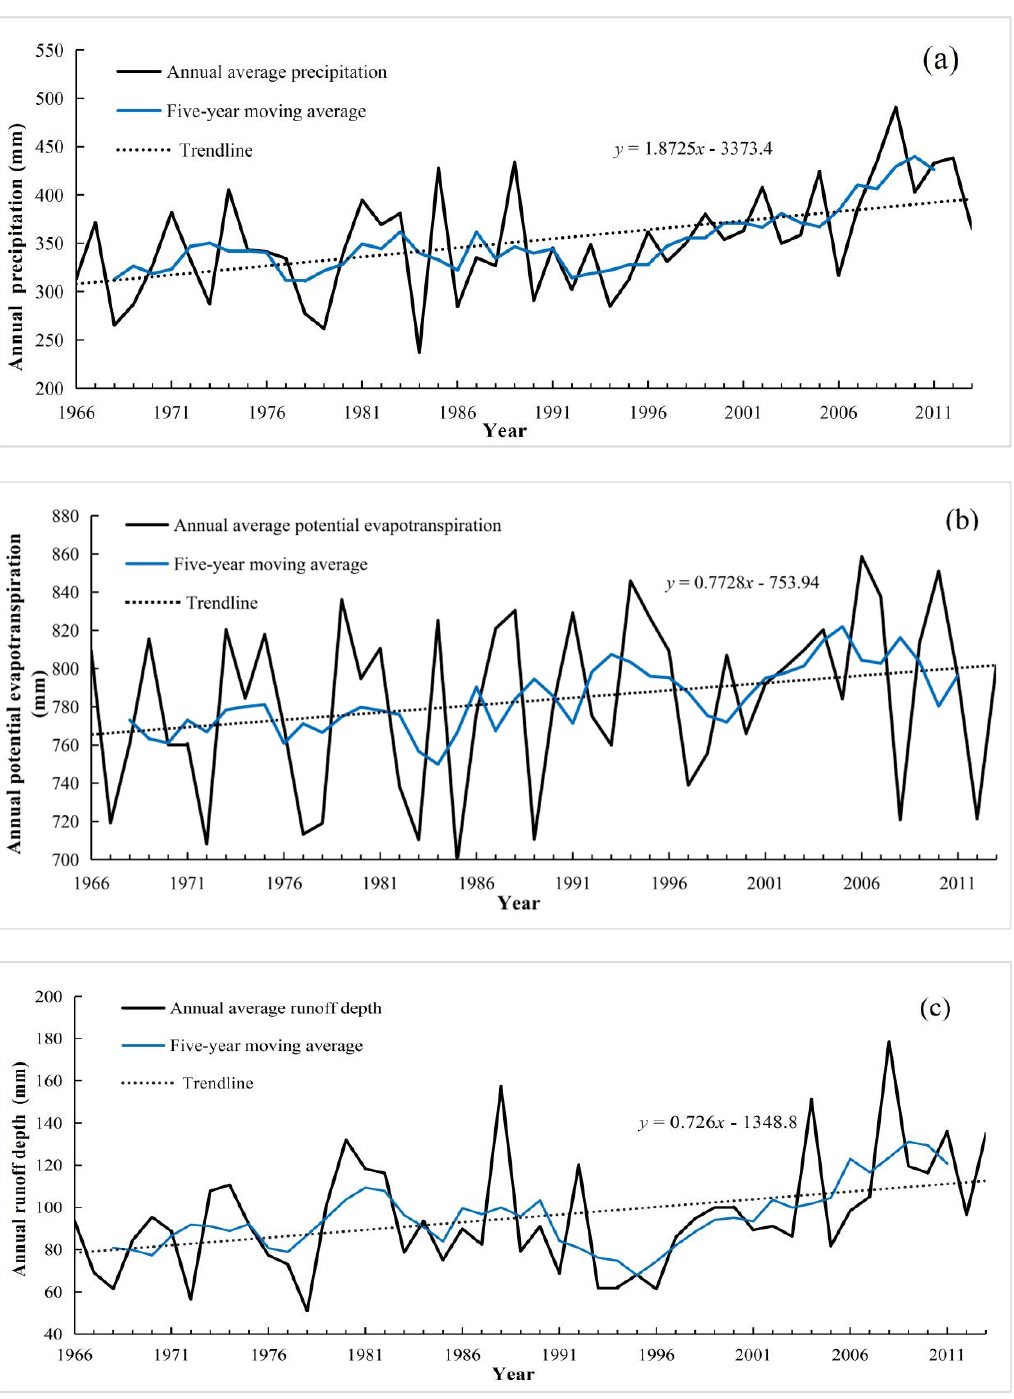
Figure 2. The change trend of annual precipitation ( a ), potential evapotranspiration ( b ) and runoff depth ( c ) from 1966 to 2013 in the YRHA.